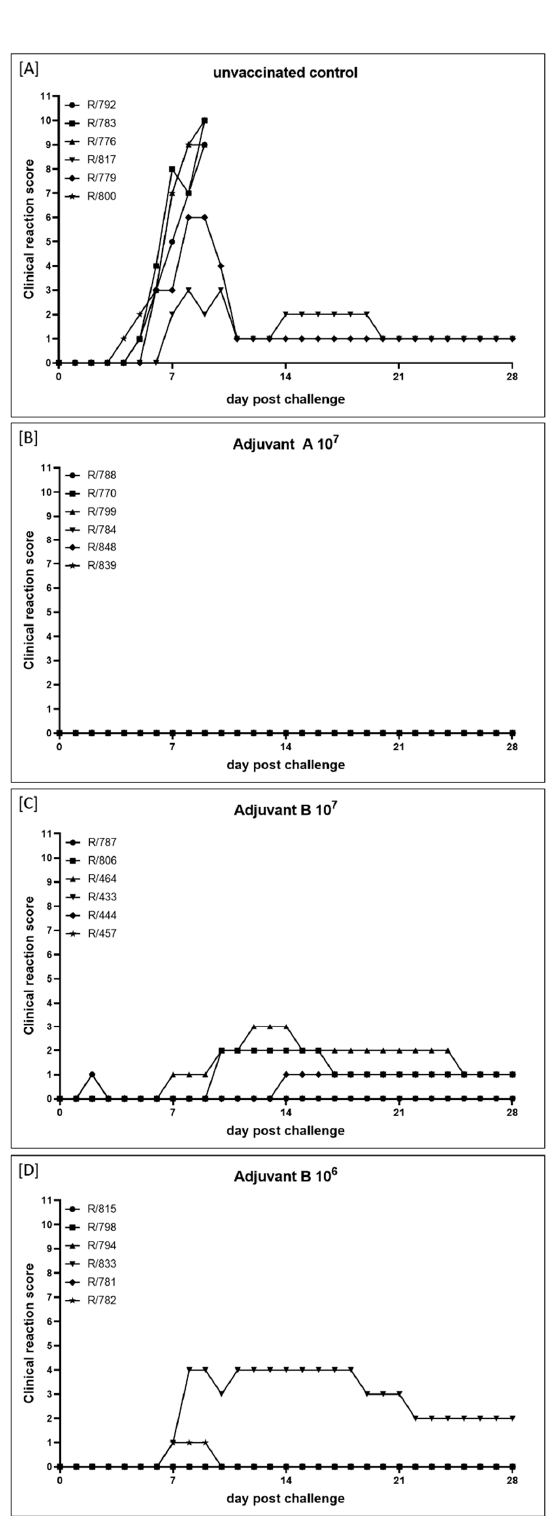
Figure 8. Clinical reaction score of the cattle during the vaccine-efficacy study. ( A ) Cattle of